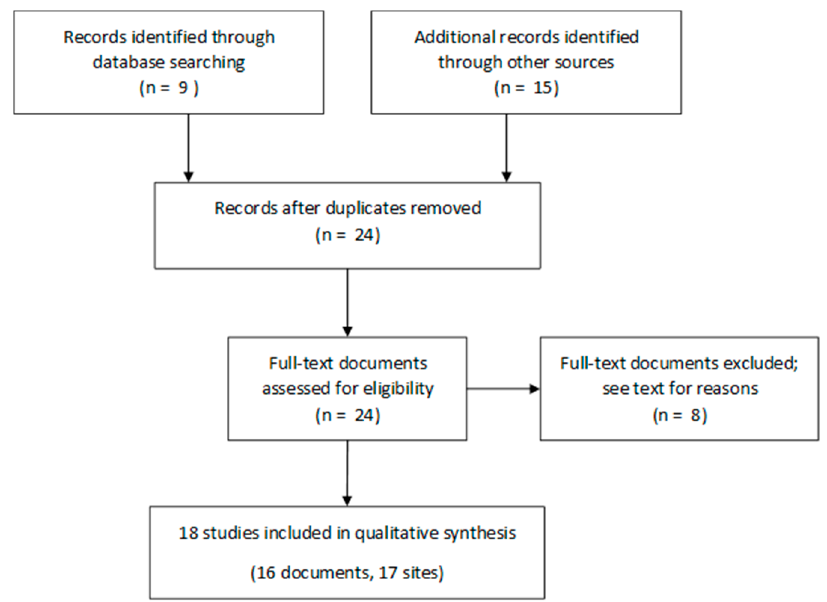
Figure 1. Preferred reporting items for Systematic Reviews and Meta-Analysis (PRISMA) flow diagram of the selection of the studies included in the review.